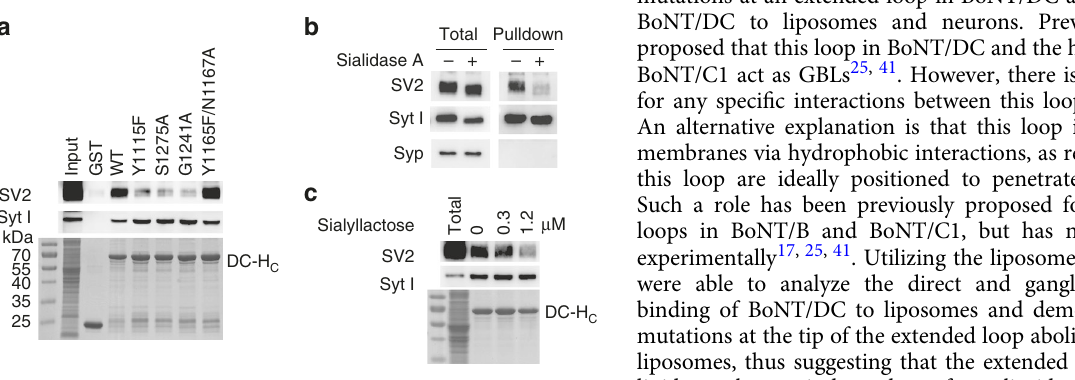
Fig. 7 Pulldown of SV2 by BoNT/DC from brain lysates was mediated by binding of the GBS of BoNT/DC to sialic acids in SV2. a GST or GST-fused BoNT/DC-H C were immobilized on beads and incubated with rat brain detergent lysates (in Triton X-100). Pellets were subjected to immunoblot analysis detecting SV2 (upper panel) and Syt I (middle panel), or subjected to Coomassie Blue staining to show GST and GST-fused BoNT/DC-H C proteins (lower panel). WT BoNT/DC-H C pulled down Syt I and SV2. Mutations at the GBS (Y1115F, S1275A, and G1241A) did not affect Syt